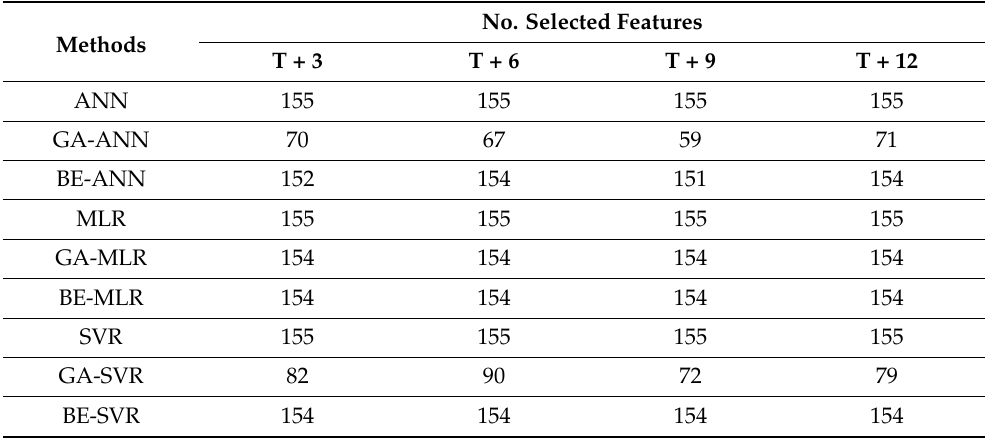
Table 5. The total number of ML method parameters in four lead